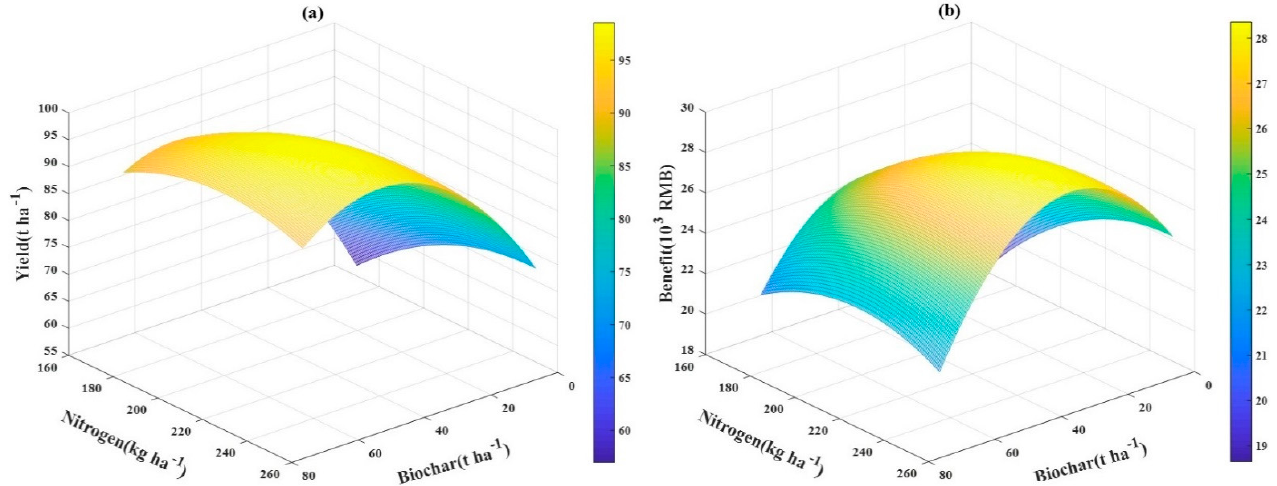
Figure 3. The relationship between tomato yield ( a ) and economic benefit ( b ) and biochar C-fertilizer N application rates in a 3D color map.